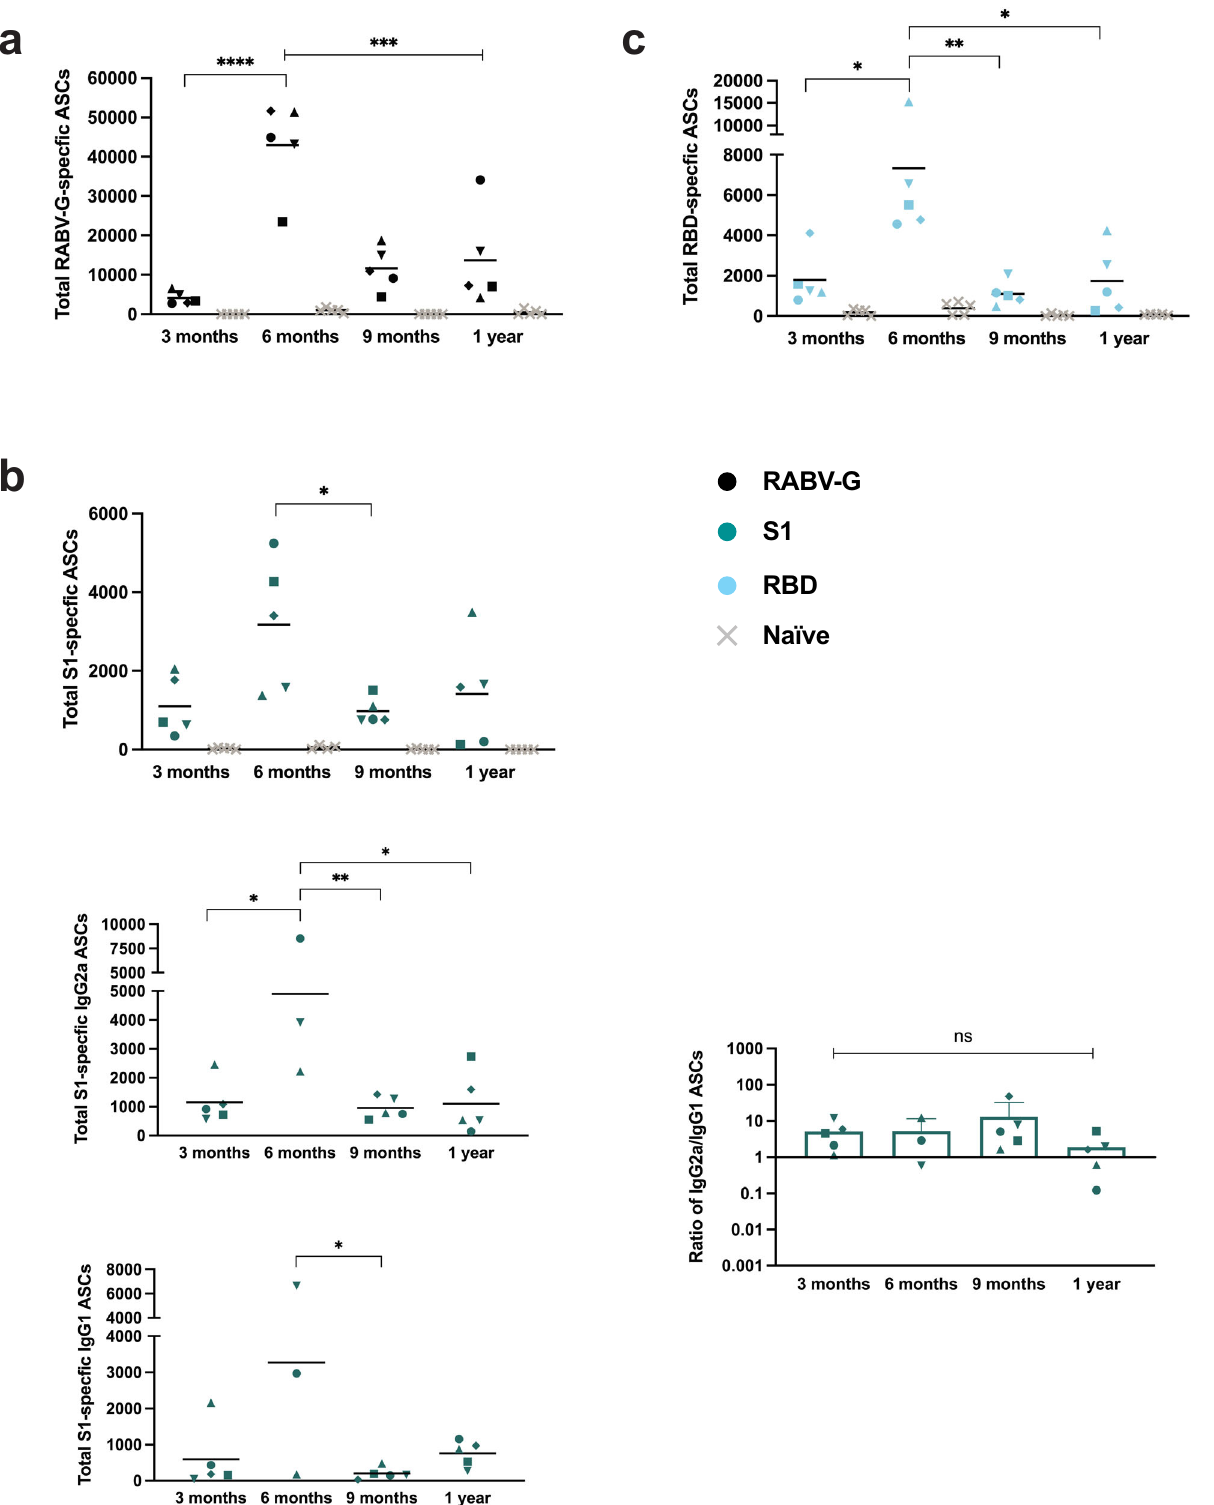
Fig. 5 Detection of antigen-speci fi c antibody-secreting cells (ASCs) in the spleens of CORAVAX-immunized mice. a The average total number (line) of RABV-G b S1 and c RBD-speci fi c ASCs present in individual mouse spleens (symbols) at 3 months, 6 months, 9 months, and 1 year compared to naive controls (gray × symbols). b Additionally for S1, average total number of IgG2a and IgG1 ASCs (lines) from individual mice (symbols) and ratio of IgG2a/IgG1 ASCs. Statistics are by one-way ANOVA with post-hoc Tukey ’ s test of log-transformed total number of cells or ratios. p > 0.1234 (ns), p < 0.0332 (*), p < 0.0021 (**), p < 0.0002 (***), p < 0.0001